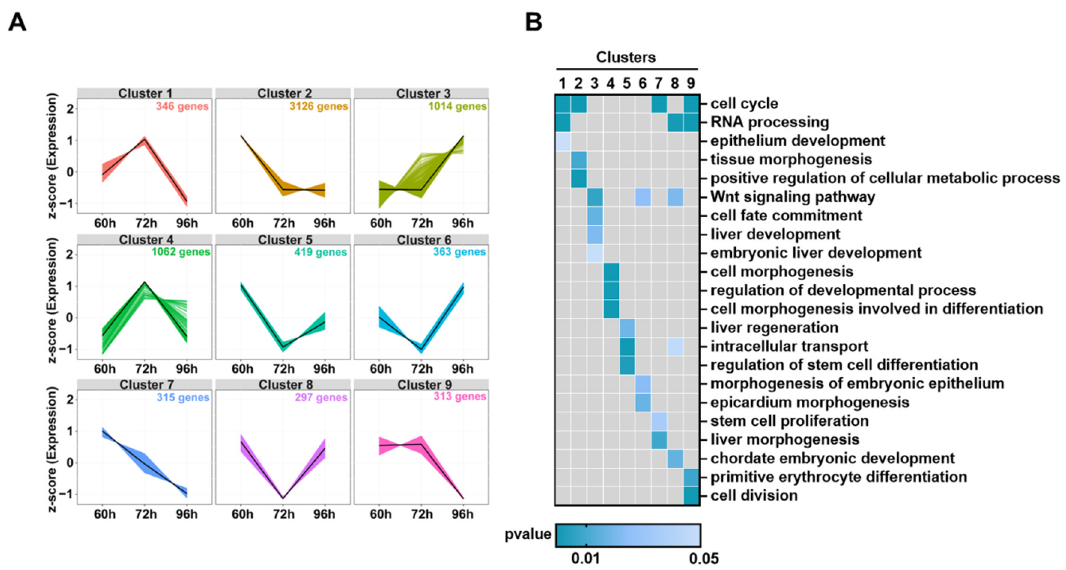
Figure 7. Dynamic changes of DEGs in hepatocytes from 60 to 96 hpf ( A ) Hierarchical clustering of changes in DEGs. ( B ) Functional annotations of different clusters by GO analysis. Heatmaps of biological processes were displayed according to their statistical significance ( p < 0.05) and locations in the GO tree.